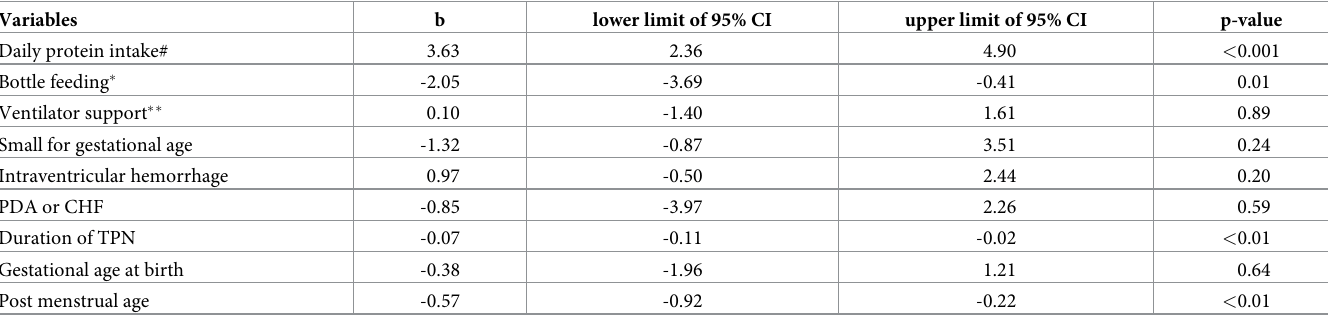
Table 5. Relationship between daily protein intake and body weight gain: Results from a generalized estimating equation. Variables Bottle feeding